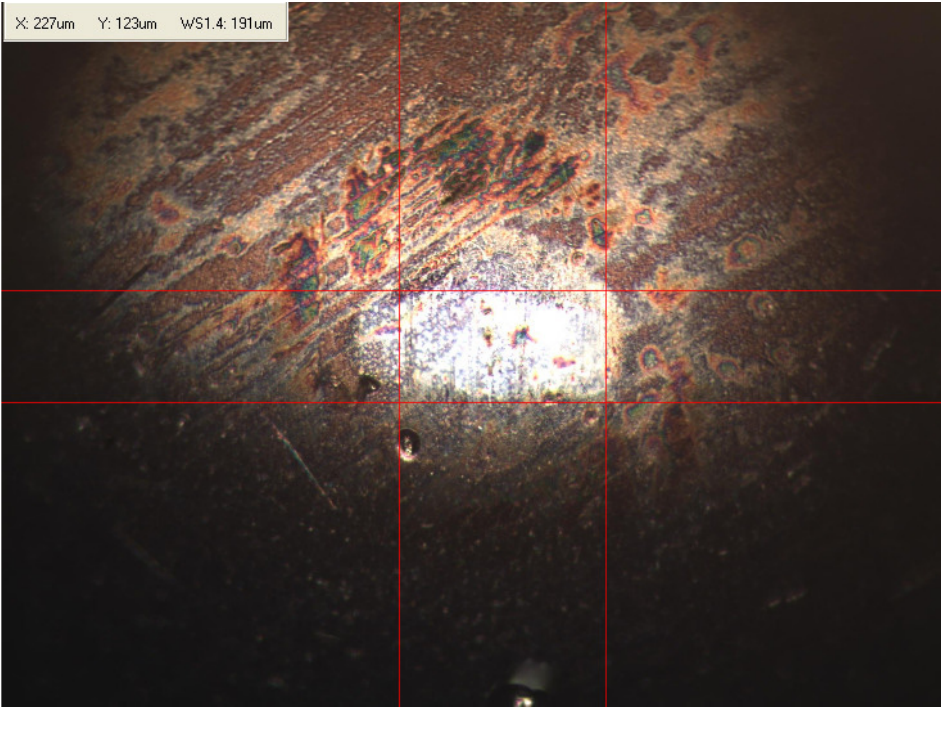
Figure A14. SAE 40—50% m/m; DO—50% m/m.